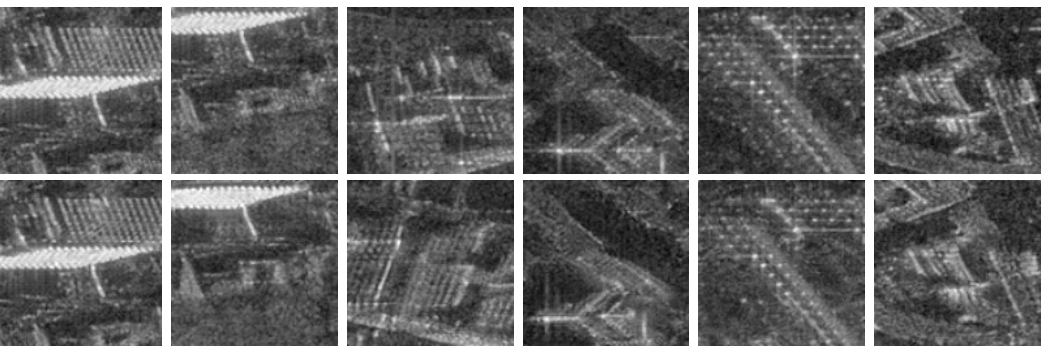
Figure 7. A selection of generated hard-negative samples ( bottom row ) and the corresponding training TerraSAR-X patch ( top row ). It can be seen that the generated patches have strong SAR-like features, which resemble those of the original patch, and are difficult to distinguish from the original